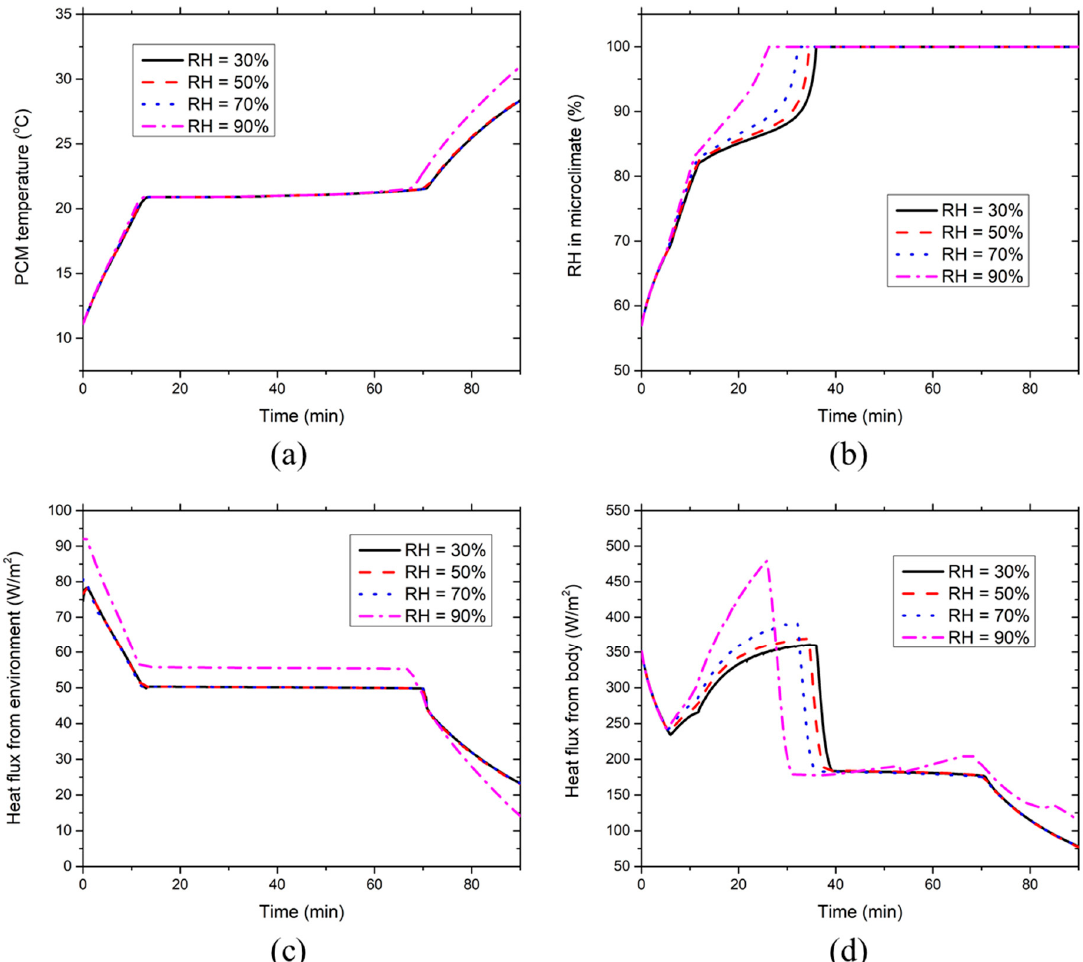
Figure 7. Effect of environmental RH on the time course of ( a ) PCM temperature, ( b ) clothing microclimate RH, ( c ) PCM heat absorption from the environment and ( d ) PCM heat absorption from the body at the chest segment covered with PCMs and insulation pads at the ambient temperature of 36 °C.